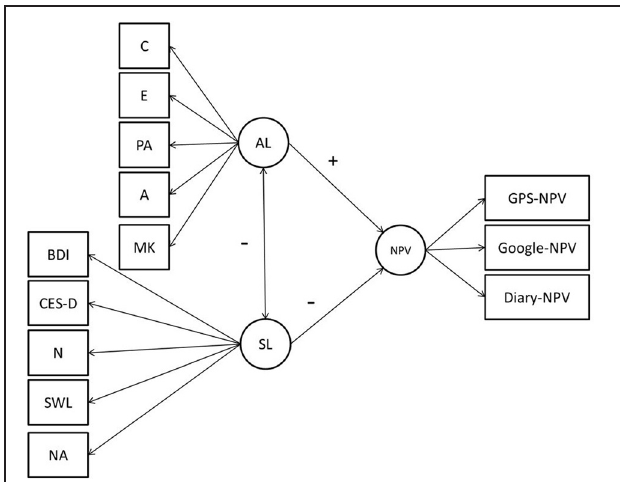
FIGURE 1 | Conceptual diagram of the nomological